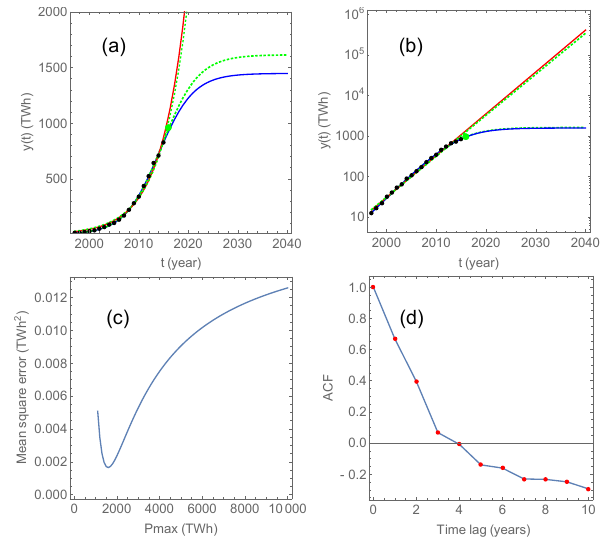
Figure 4. The black bullets represent global wind power consump- tion data for the period 1997–2015, and the green bullet for 2016; all according to BP Statistical Review of World Energy (2017). In panel (a) , the red and blue curves are exponential and logistic model fits to the 1997–2015 data, respectively. The green, dashed curves are fits to the 1997–2016 data. The logarithmic plot in panel (b) shows the fits of the logarithms of these models to the logarithms of the data. Panel (c) shows Q 2 versus P max , when fitting is made with fixed P max . The blue curve in panel (b) is the fitted curve with the value of P max fixed to the minimum of the graph in panel (c) . Panel (d) shows the ACF for the residual deviation between the data and the exponential